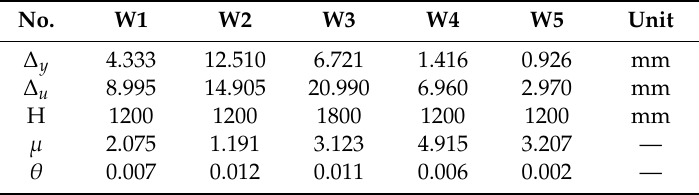
Table 5. Ductility coefficients and shifts angle of specimens.